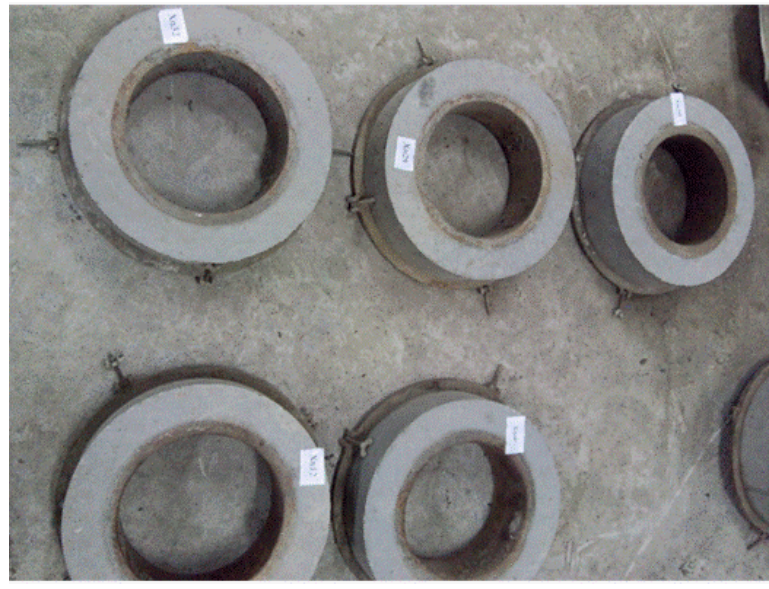
Figure 2. The picture of the restrained concrete ring